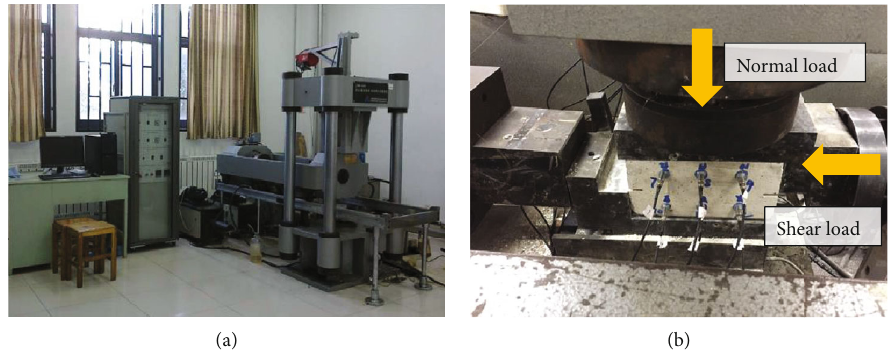
Figure 3: Arrangement of the shear test: (a) shear test system; (b) loading unit.